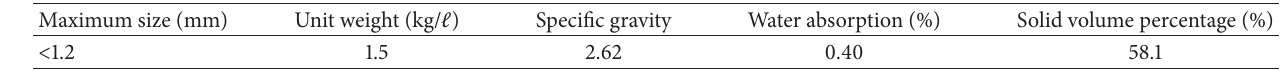
Table 4: Properties of fine aggregate.